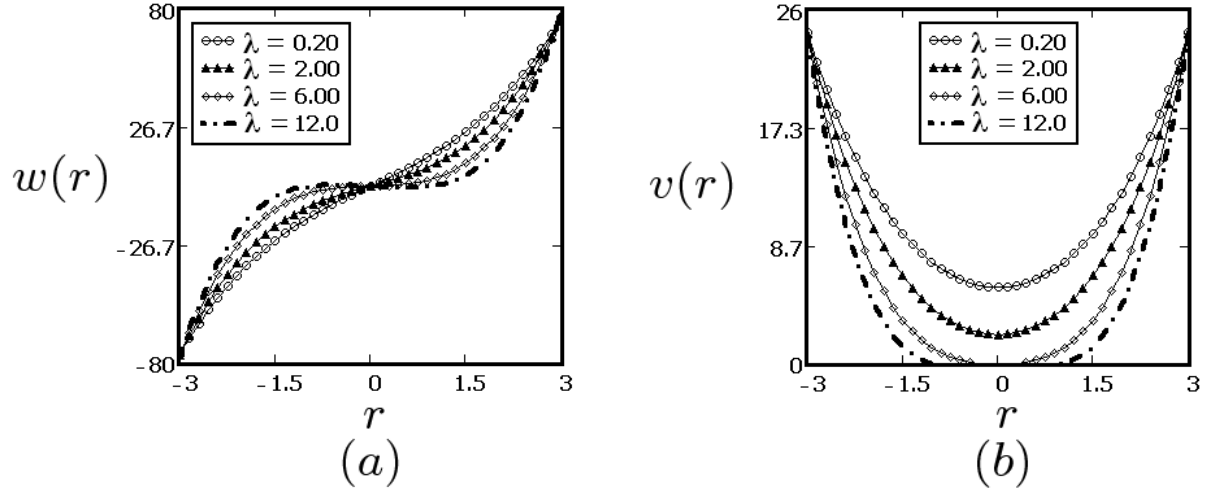
Fig. 6: Profiles of the velocity components w ( r , t ) and v ( r , t ) given by Eqs. (32) and (33), for R = 3, Ω = 1, U = 1, ν = 0.9292, µ = 26, α = 0.7, p = 2, t = 5 s and different values of λ .